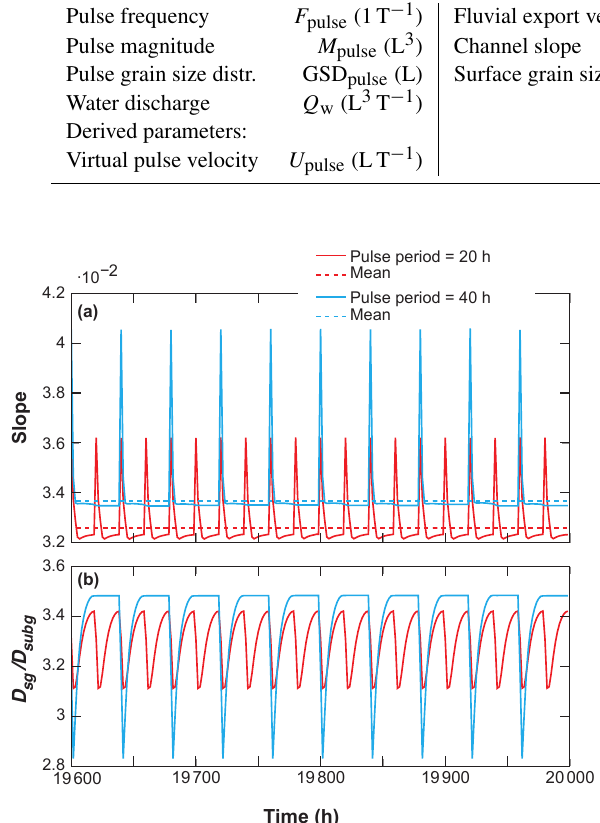
Table 3. List of forcing and reacting parameters, and timescales in our simulations with abbreviations and their dimension (T represents time and L represents length). Forcing parameters Reacting parameters Timescales M pulse (L 3 ) Pulse period T pp (T) Pulse grain size distr. GSD pulse (L) Surface grain size distr.